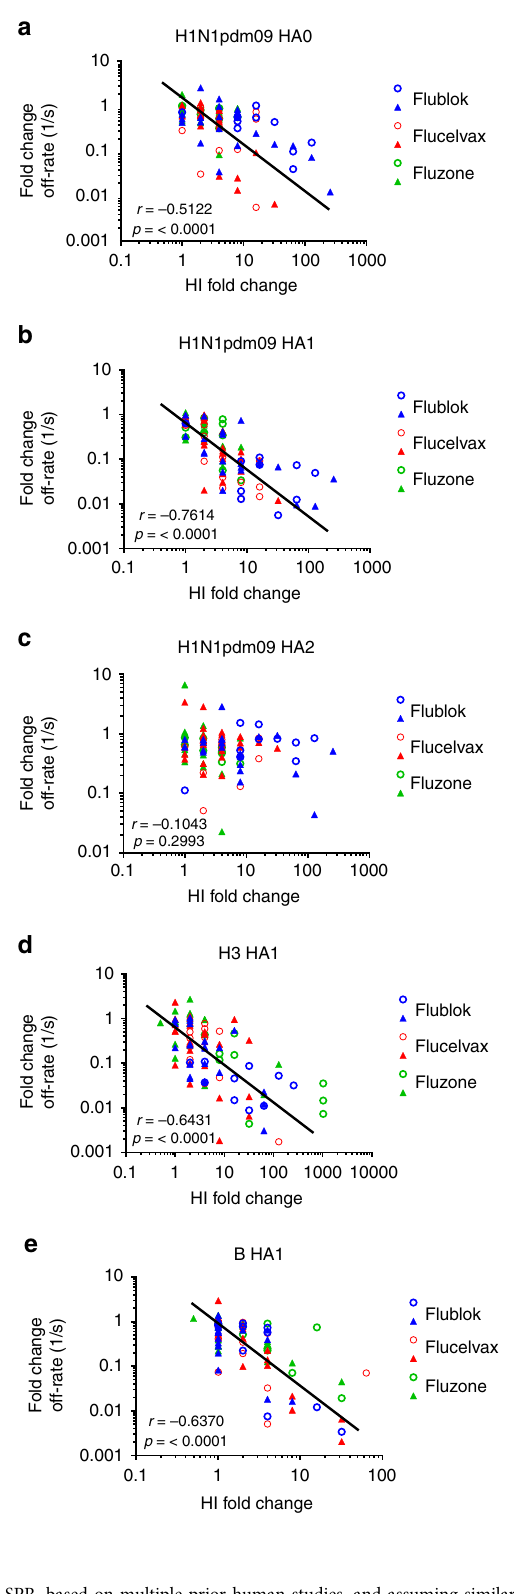
Fig. 7 Correlations between fold change of HI and anti-HA1 antibody off- rates. a – e HI fold changes of all study participants are correlated with their change of antibody-binding off-rates against ( a ) H1N1pdm09 HA0; ( b ) H1N1pdm09 HA1; ( c ) H1N1pdm09 HA2; ( d ) H3 HA1; ( e ) B-HA1. Spearman correlations, assuming non-parametric correlation, are reported for the calculation of correlations between off-rate fold changes and HI fold changes across all vaccine groups in year 1 and year 2. The correlation coef fi cient and p values are reported for each set of all groups Source data are provided as a Source Data